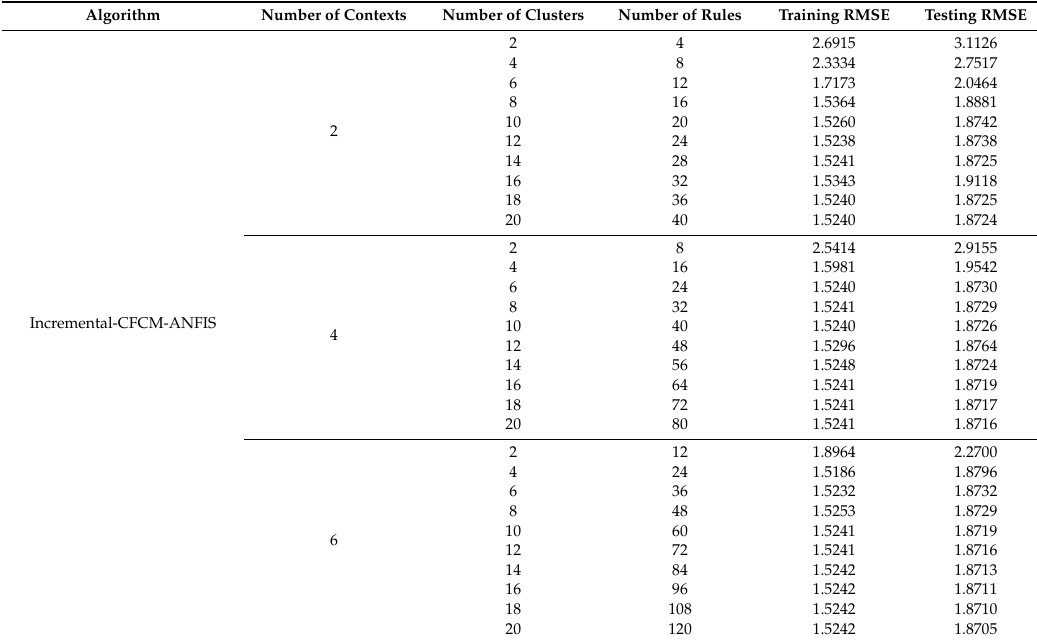
Figure 8. Comparison of ANFIS predicted values with actual output values in an incremental tree structure based on CFCM clustering.